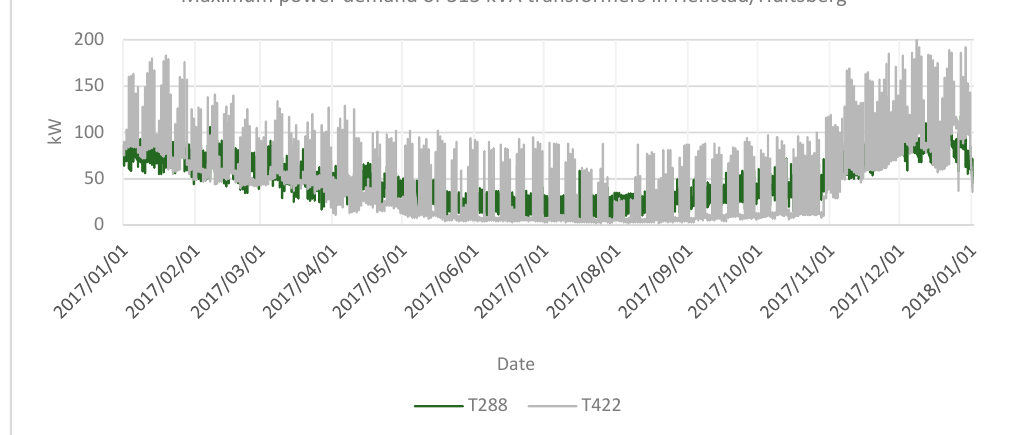
Figure 3. The power demand of 315 kVA transformers.